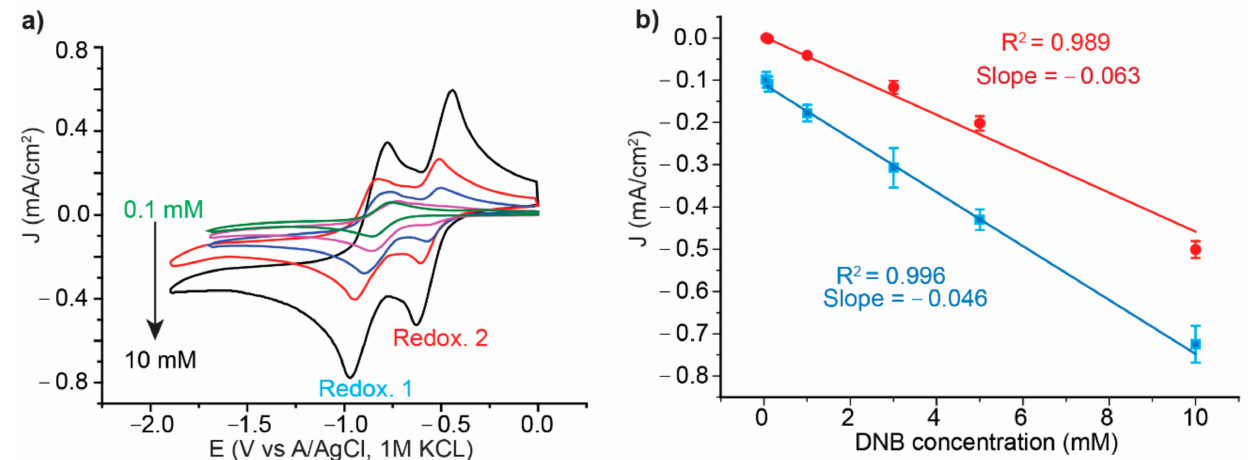
Figure 3. ( a ) CV for the evolution of the peak current vs the concentration of DNB on GCE between 0.1 mM and 10 mM. ( b ) Calibration curves created by plotting the peak current of the redox peak 1 (blue) and the redox peak 2 (red) against its corresponding concentration.